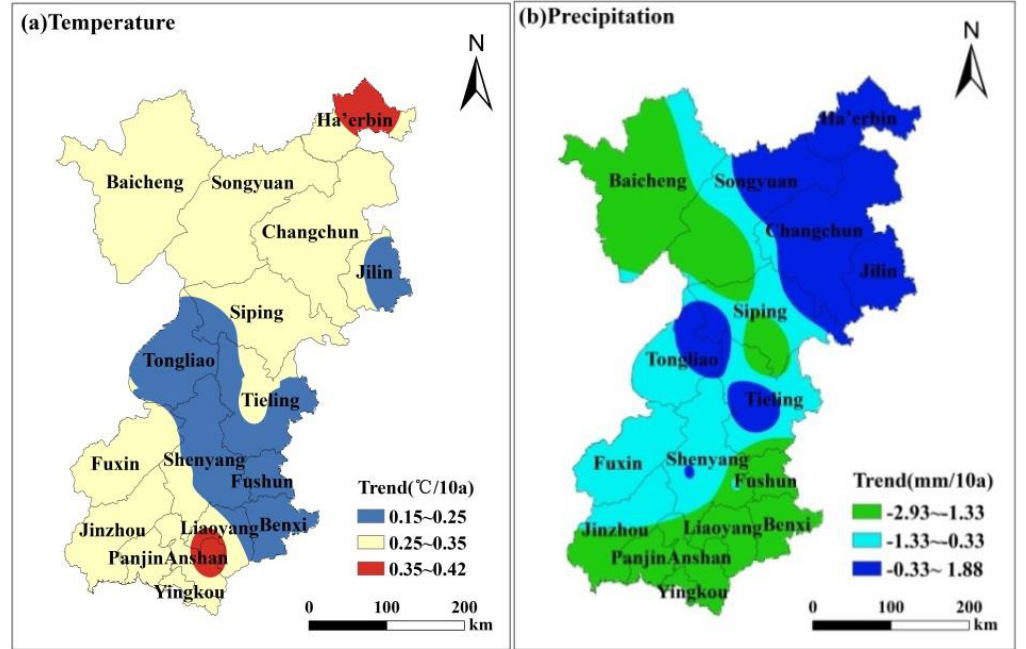
Figure 3. Spatial variation trend of temperature ( a ) precipitation ( b ) in the growing season during the period 1965 – 2017.